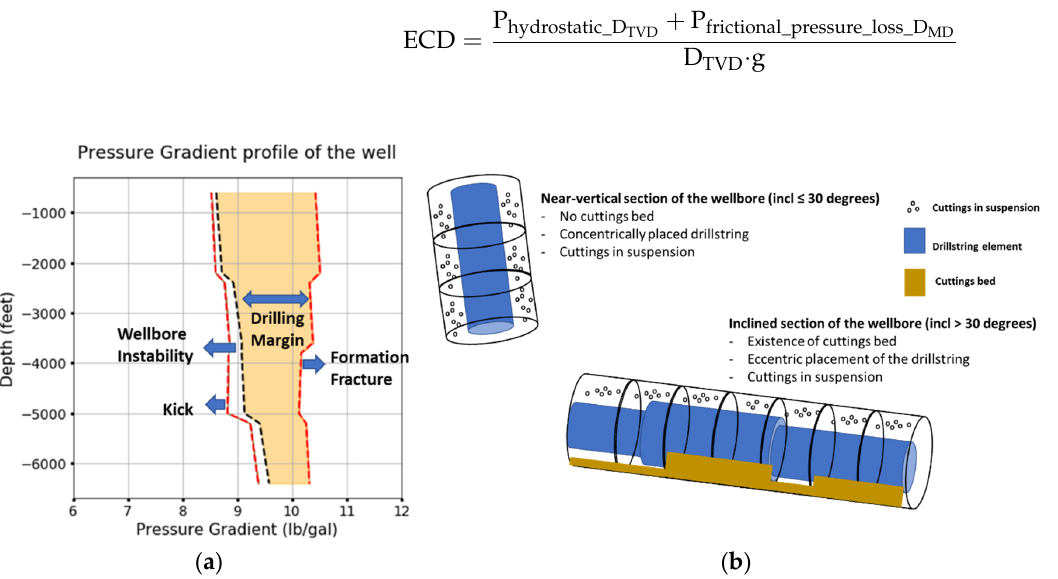
Figure 4. ( a ) Drilling safety margin; ( b ) Cuttings bed distribution in different inclination segments of the well.